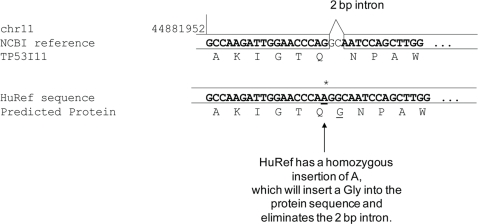
An example of a homozygous indel located near an exon boundary.The HuRef assembly has a homozygous insertion of A at chr11: 44881936. This insertion resides inside a coding exon of the gene TP53I11, but is near a 2 bp intron. With this new base inserted, a single amino acid is introduced into the protein sequence, which is the more likely scenario instead of a 2 bp intron.